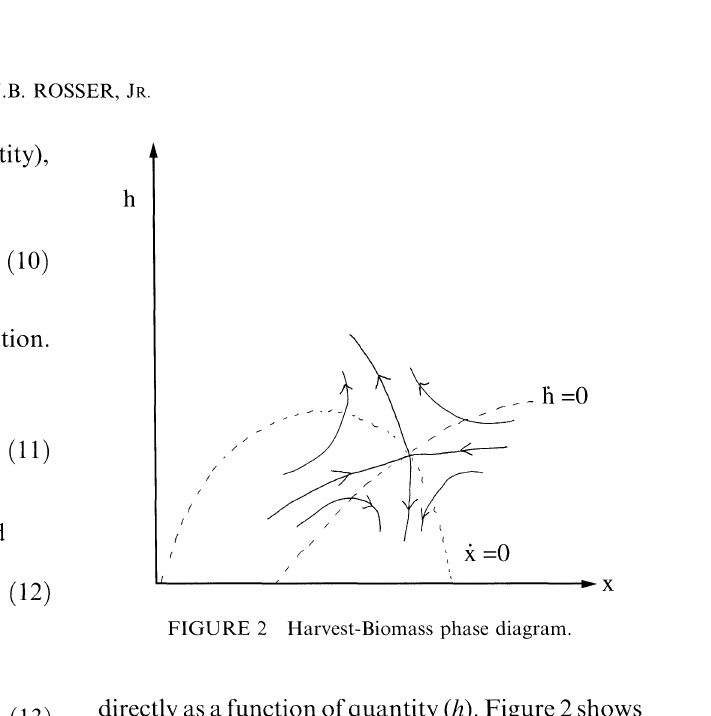
FIGURE 2 Harvest-Biomass phase